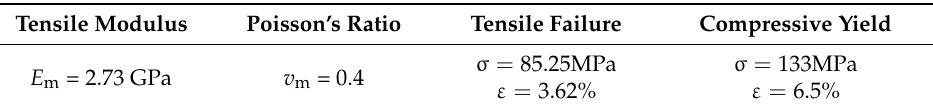
Table 2. Mechanical properties of